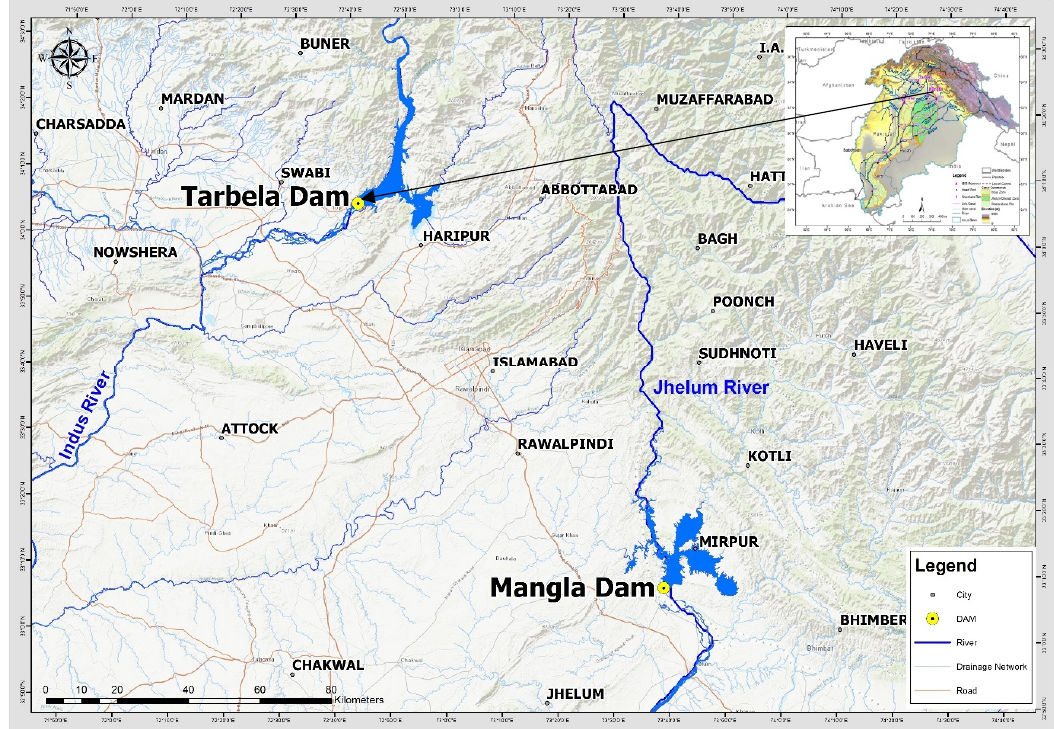
Figure 2. The Indus River System, showing Tarbela Reservoir [45].